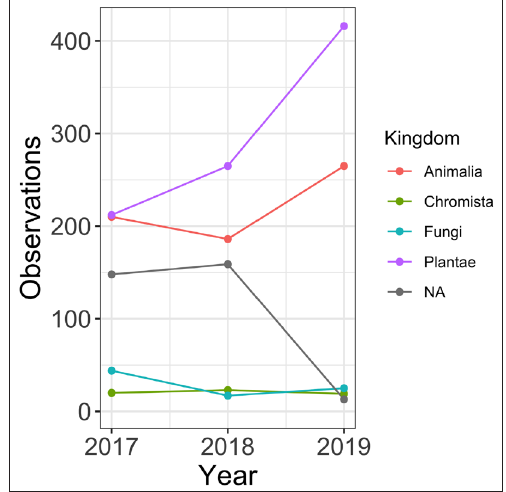
Figure 2 Number of observations (organisms) identified to species from each of four major taxa (animalia, chromista, fungi, or plantae) or not (yet) identified (indicated as NA) for each project